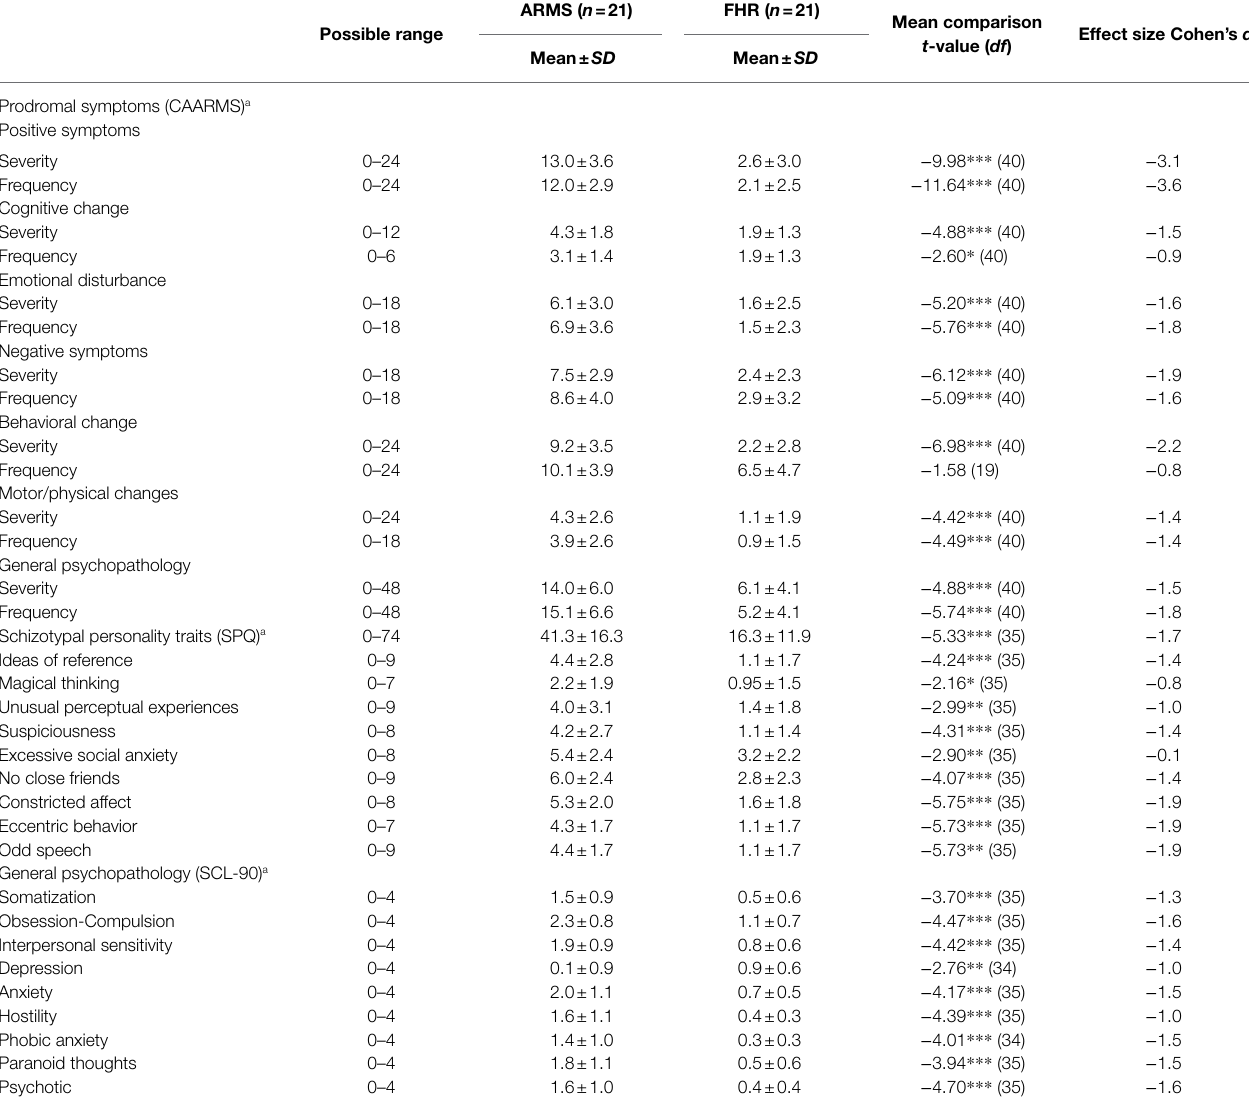
TABLE 3 | Description and comparison of clinical measures between ARMS and FHR groups ( N = 42). ARMS ( n = 21) FHR ( n = Possible range